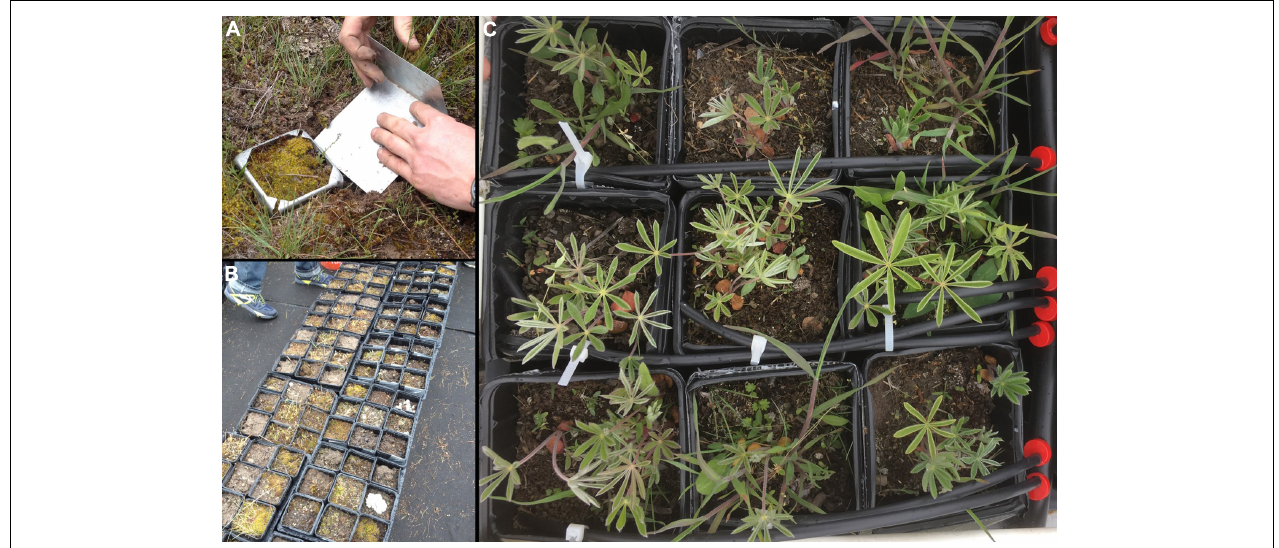
FIGURE 1 | Experimental mesocosms. (A) Collection of intact biocrusts from the field. (B) Biocrusts were placed on top of backfilled tree pots. The variety of cover values and compositions is evident in this view, prior to both weeding and seeding. (C) Developing and variable vascular plant communities in a subset of pots.